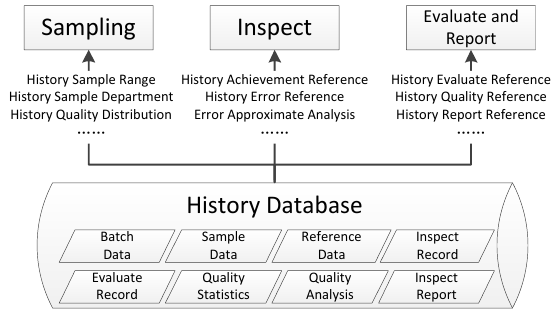
Figure7 History Support In Different Inspect